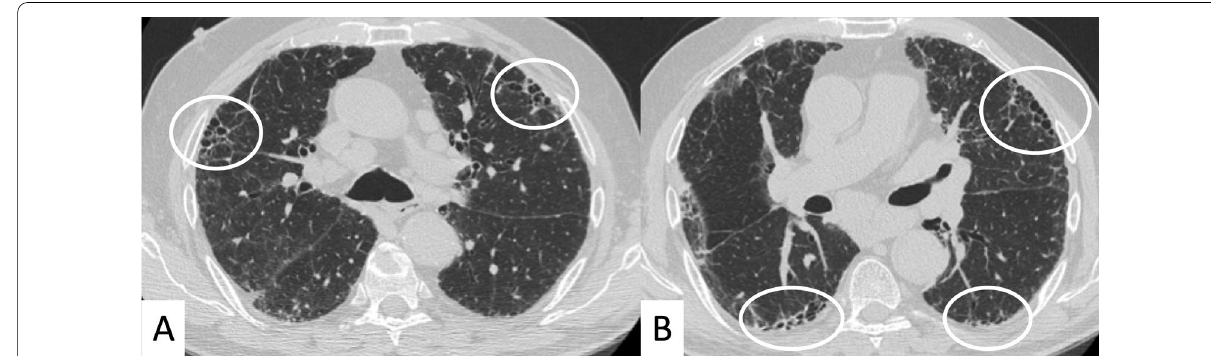
Fig. 12 The Four Corner Sign. This sign is defined by the presence of pulmonary fibrosis in the “4 corners regions of the thorax”—represented by anterolateral regions of mid-upper lobes and the posterosuperior regions of lower lobes. In this SSc patient, honeycomb areas are clearly recognizable in the upper lobes (white circles in A , B ) and in the upper parts of lower lobes (white circles in B